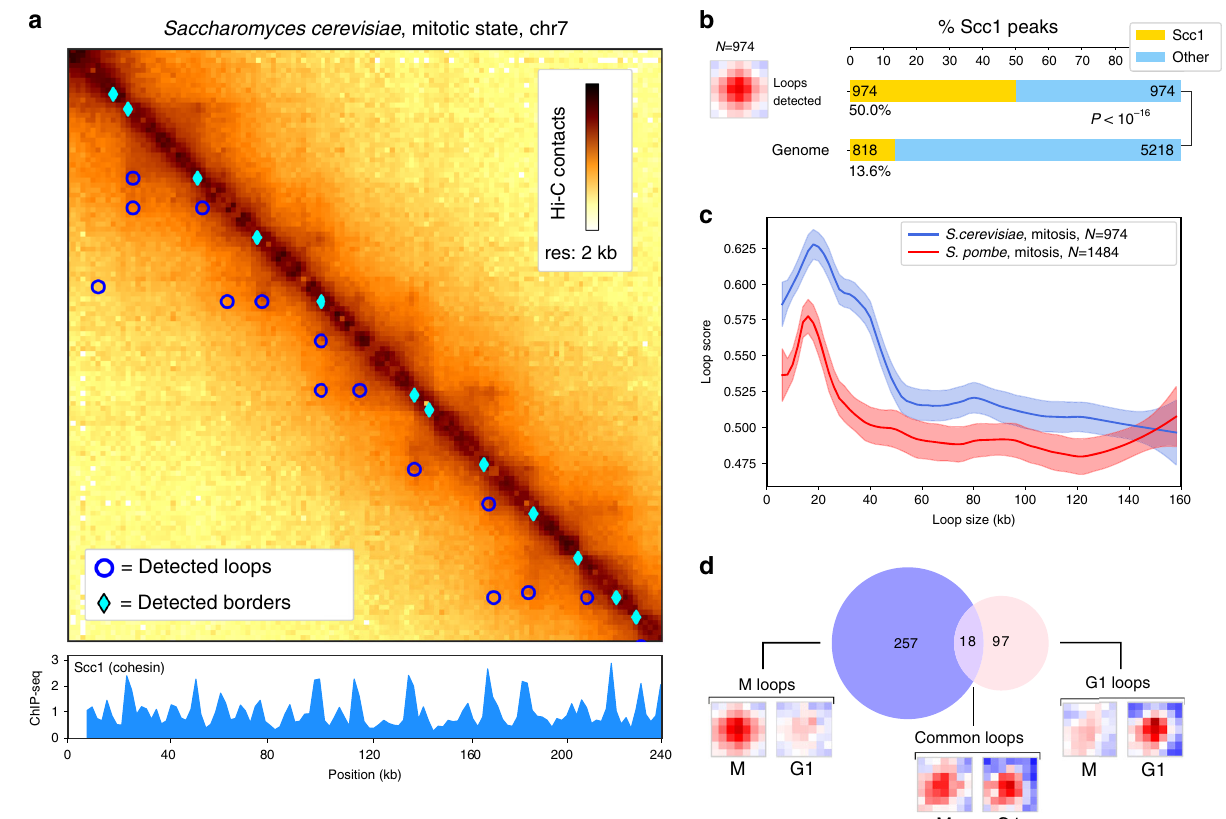
Fig. 2 Applications on yeast genomes. a Zoom-in of the contact map of chromosome 5 of S. cerevisiae with synchronised ChIP-Seq signal of Scc1 protein (cohesin) at 2 kb resolution with detected loops and border patterns, 8 . The darker, the more contacts. b Pileup plots of windows centered on detected loops with the number of detections. Barplots of the proportion of Scc1 peaks for anchors of detected loops and associated p -value (Fisher test, two-sided). c Loop spectrum showing scores in function of the loop size in S. cerevisiae (974 loops) and S. pombe (1484 loops). Curves represent lowess-smoothed data for easier interpretation with 95% con fi dence intervals. d Number of loops detected only in G1 phase, M phase, or in both. For each category, the pileup of each set of coordinates is shown for both G1 and M conditions (mitotic data 8 subsampled from 44M to 5.8M contacts for comparison with G1 7